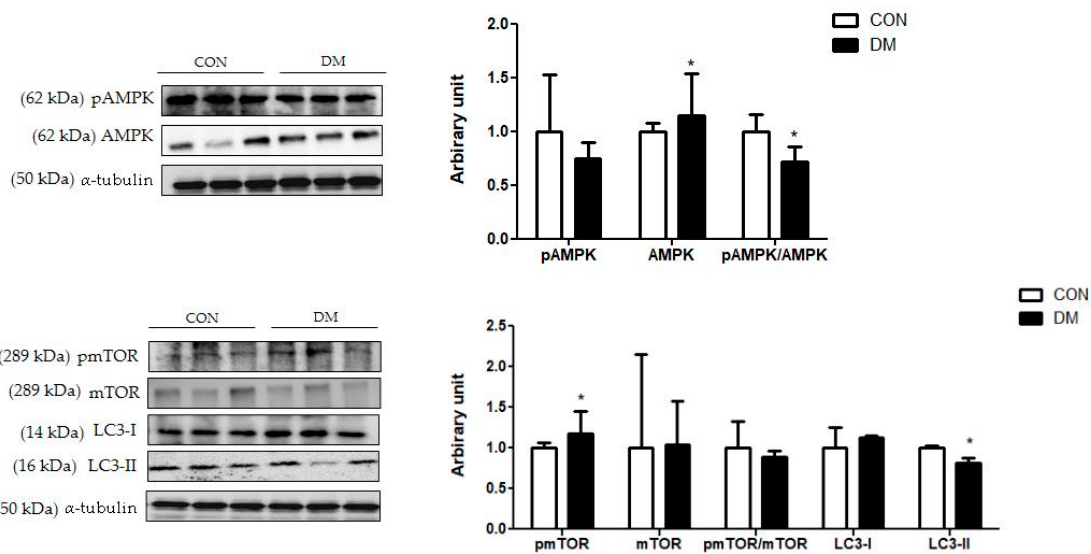
Figure 9. Hippocampal autophagy related markers in T2DM mice. All values are reported as mean and SD. The asterisk represents statistical significance of differences from * p < 0.05. n = nine mice in each group. CON, normal control mice; DM, diabetes mellitus mice.